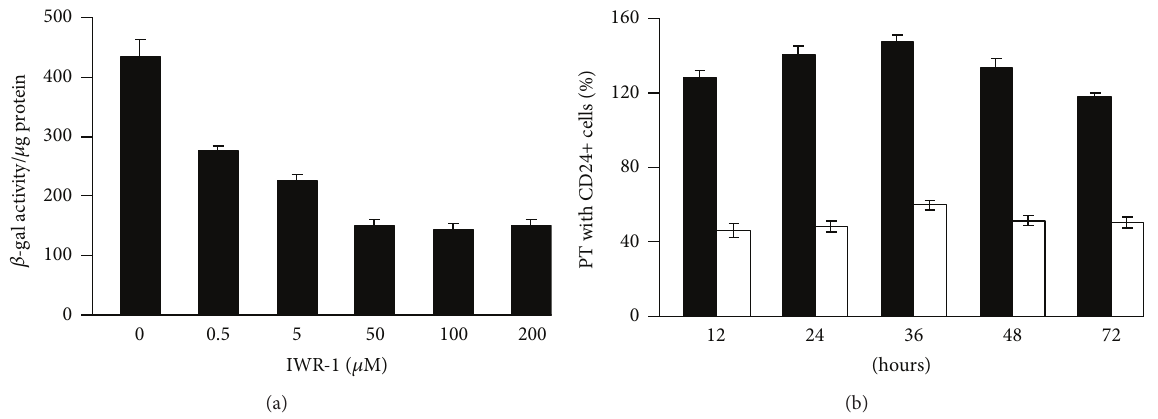
Figure 8: IWR-1 inhibits WNT3a-stimulated 𝛽 -catenin/TCF signaling activity in embryonic CD 24+ cells from E15 mouse kidney. CD 24+ cells from mice bearing the 𝛽 -catenin/TCF reporter transgene were isolated by FACS from E15 mouse kidneys and cultured for 12 hours. IWR-1 was then added and CD 24+ cells were exposed to L-cells expressing WNT3a for 12 hours to assess 𝛽 -catenin/TCF signaling activity. (a) 𝛽 - galactosidase activity per 𝜇 g cell protein was maximally inhibited to 34% of control by IWR-1 concentrations 100 𝜇 M (24 hours). (b) CD 24+ cells were exposed to control medium (black bars) or IWR-1 (100 𝜇 M) (white bars) for 12 hours and then transferred to control medium for various periods of time to track persistence of WNT3a-stimulated 𝛽 -galactosidase activity; significant inhibition was evident after 12 hours (36% of control) and 72 hours (43% of control) of washout in control